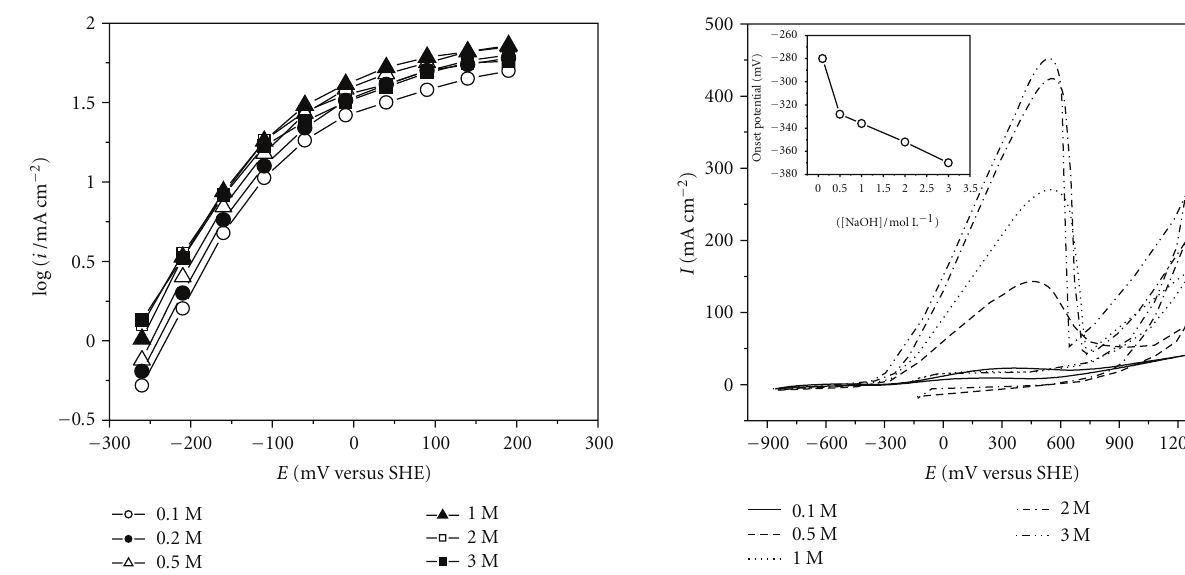
Figure 8: Cyclic voltammograms for methanol oxidation in 1.0 M methanol at various NaOH concentrations on Pt-Pd/C catalyst at 25 ◦ C and sweep rate of 50 mVs − 1 ; inset: variation of onset poten- tials for methanol oxidation with NaOH concentration in 1.0 M